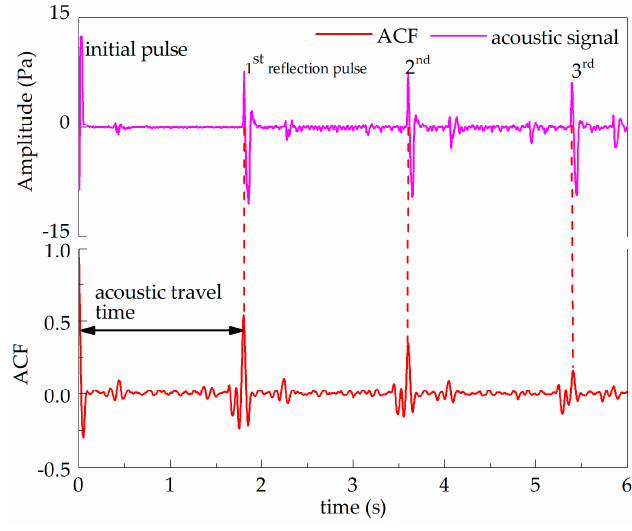
Figure 6. Original and ACF of the test acoustic Fig ure 6. Original and ACF of the test acoustic signal.